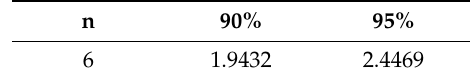
Table 1. Critical values for banks. Source Pearson’s